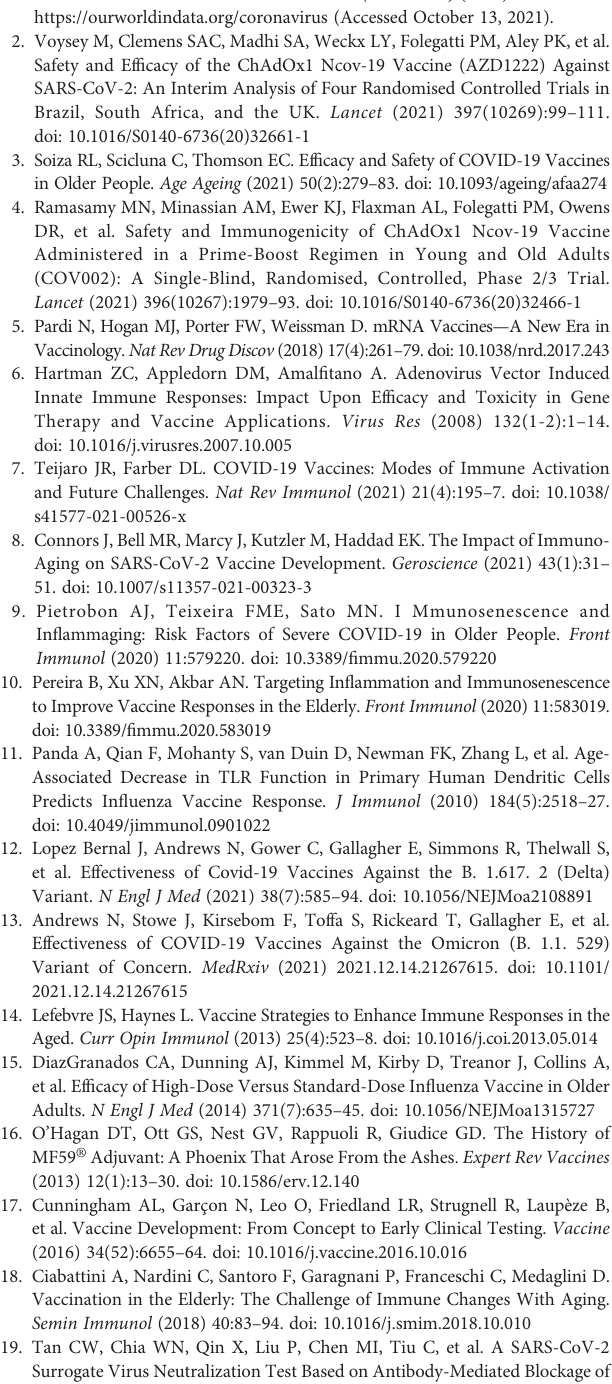
expressing monocytes (C) of the young and older adult vaccinees were analyzed by fl ow cytometry. Statistical signi fi cance was determined using ANOVA with Tukey ’ s multiple-comparisons testing between all groups. (Black: young vaccinees; Grey: older adult vaccinees). (*p value < 0.05; **p value < 0.01; ***p value <